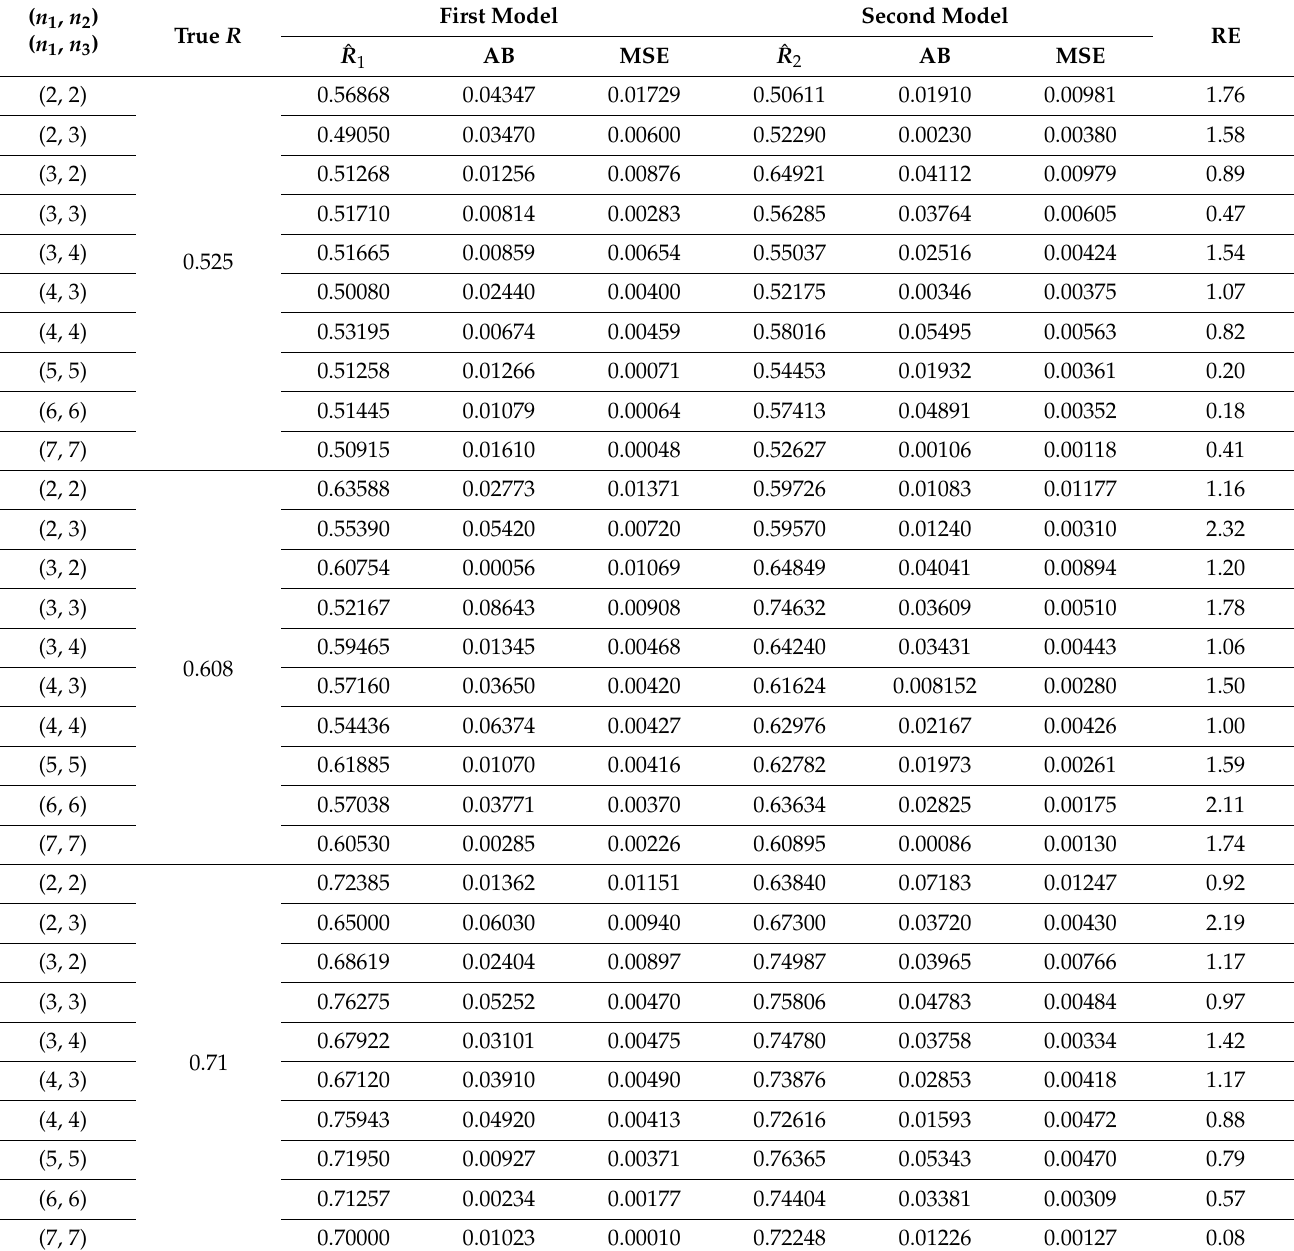
Figure 9. Estimated PDF, CDF, and PP plots of the ILo distribution for Z . Table 7. Reliability estimates, AB, MSE, and RE of the survival periods of two groups of patients with head and neck cancer data based on MRSS.